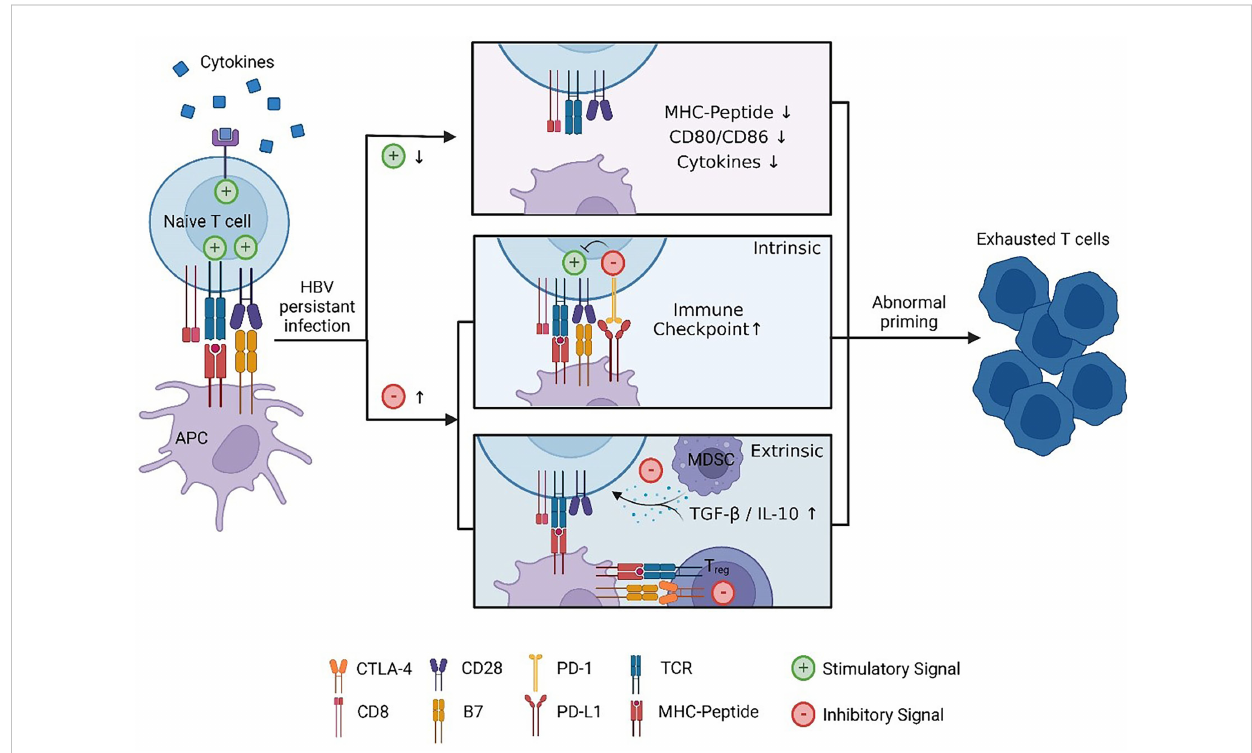
FIGURE 2 Abnormal HBV-speci fi c CD8 T-cell priming. Due to persistent stimulation with HBV, the stimulus signal is reduced: exhausted APCs cannot provide suf fi cient signal 1/2 that is manifested in the downregulation of MHC II and CD80/CD86, and cytokine-mediated signal 3 decreases. Moreover, inhibitory molecule-mediated signalling increases: regulatory cells such as MDSCs and Treg cells will secrete anti-in fl ammatory cytokines, and CTLA-4 expressed in Treg cells will competitively bind CD28 with higher af fi nity compared to CD80 in APCs. Under these circumstances, T cells cannot differentiate into effector cells, while exhausted T cells lose antiviral function. This fi gure was created with BioRender.com